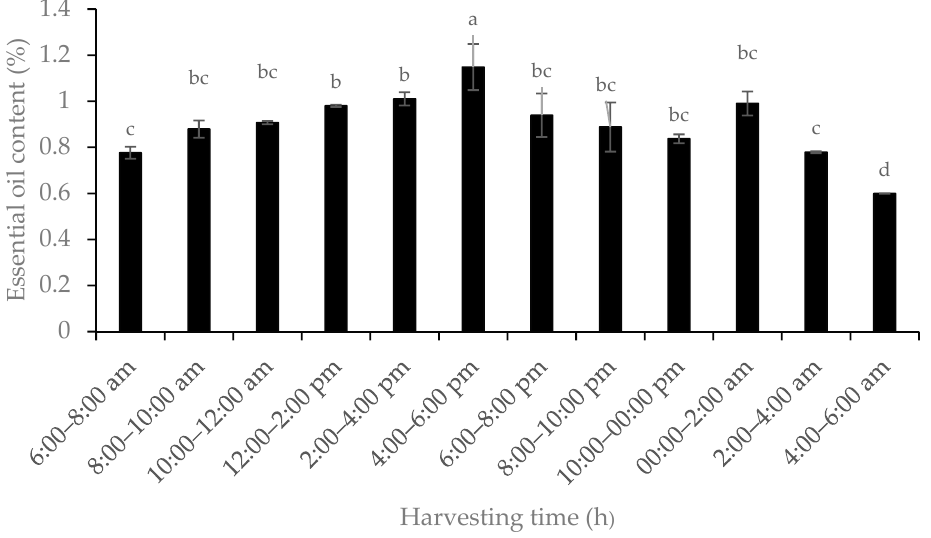
Figure 3. Changes in the essential oil percentage of S. officinalis during the day and night. Means followed by common letter are not significantly different at the level of 5% (Duncan’s multiple range test).